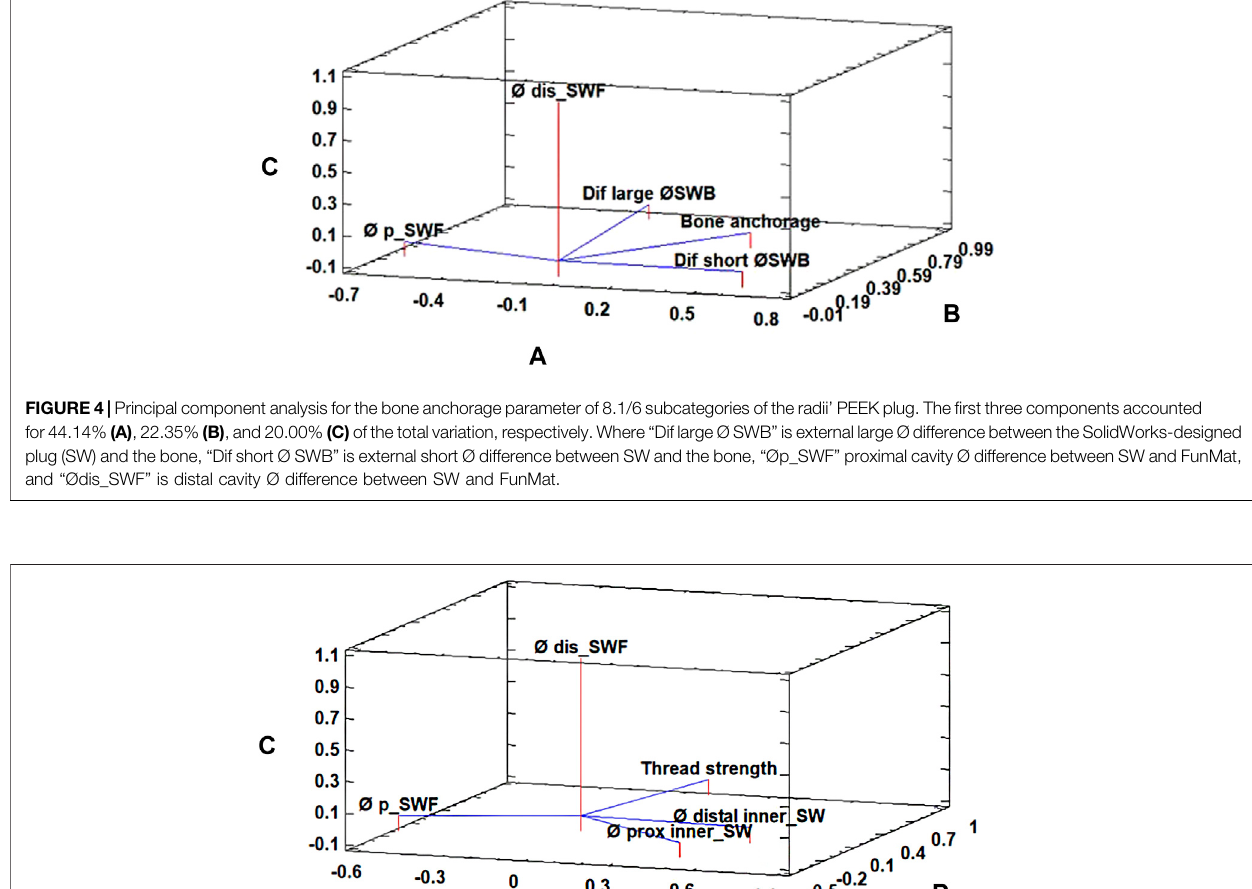
Frontiers in Mechanical Engineering |